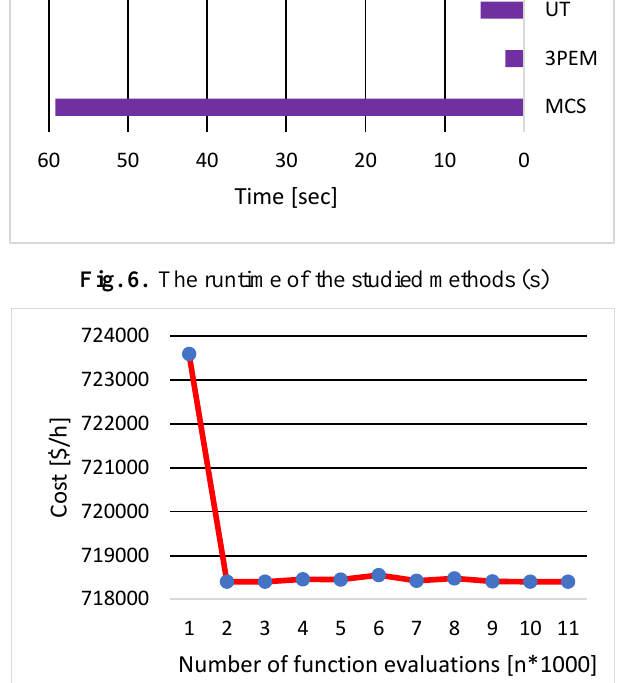
Fig. 5. Profiles of bus voltage (per unit)